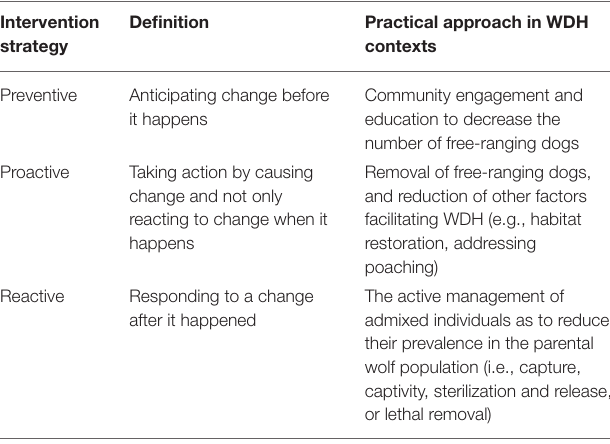
TABLE 1 | Key strategies, and corresponding management interventions, available to address the mitigation of anthropogenic hybridization (adapted for a case study on wolf × dog